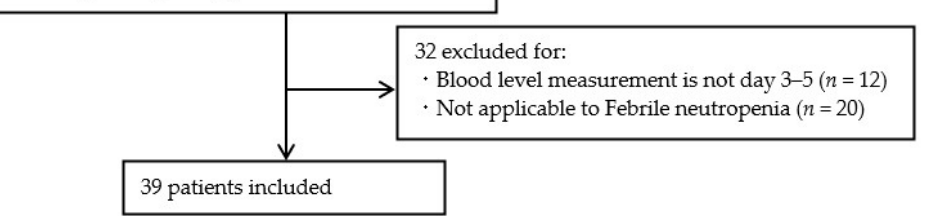
Figure 1. Schema showing the process of screening patients for the study. Abbreviations: TEIC, teicoplanin. Table 2. Baseline characteristics of the patients.